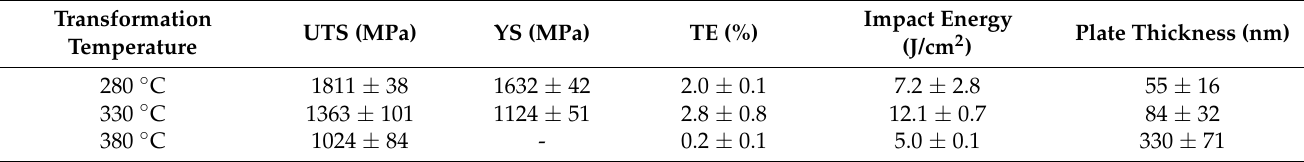
Table 4. Ultimate tensile strength (UTS), yield stress (YS), total elongation (TE), and impact energy as function of the transformation temperature for 360 min, i.e., once the bainitic reaction has been completed.